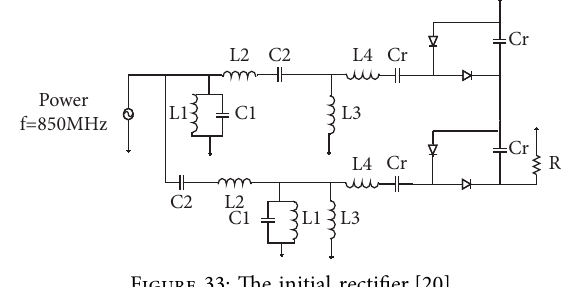
Figure 33: Te initial rectifer.[20].